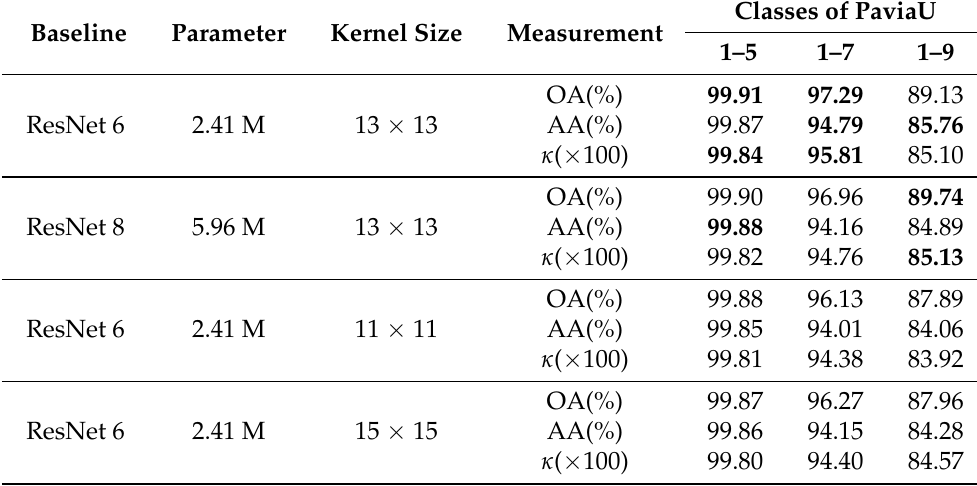
Table 4. Classification results of different network parameters.